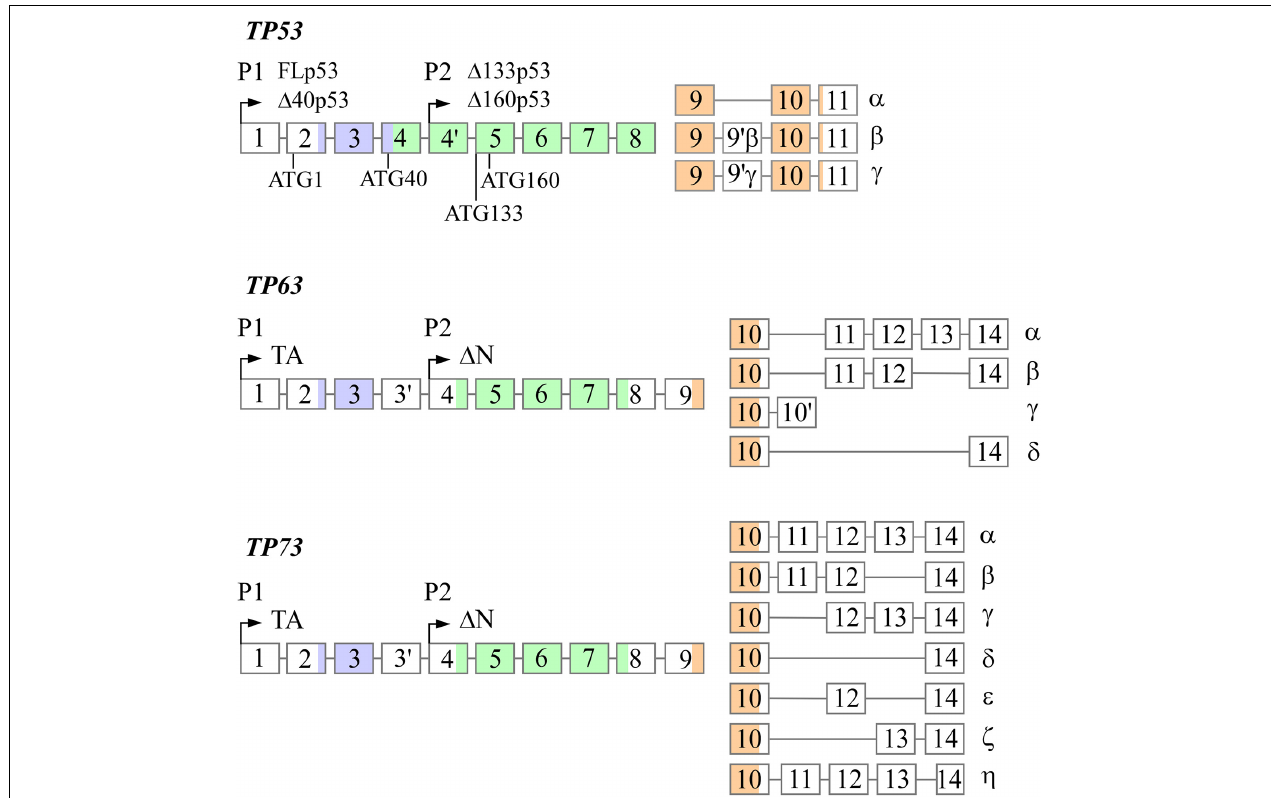
FIGURE 1 | The genomic loci of TP53 , TP63 , and TP73 . All three genes contain two promoters (P1 and P2) through which transcription initiation may occur, resulting in the formation of the N-terminal isoforms. TP53 contains four alternative translation start sites termed ATG1, ATG40, AG133, and ATG160 that give rise to FLp53, (cid:49) 40p53, (cid:49) 133p53, and (cid:49) 160p53, respectively. Alternative splicing at the 3 (cid:48) end produces the C-terminal isoforms in each gene with the exception of p63 γ , which results from transcriptional termination in intron 10. There exists significantly homology between each gene in the transactivation domains (purple), DNA-binding domains (green), and oligomerization domains